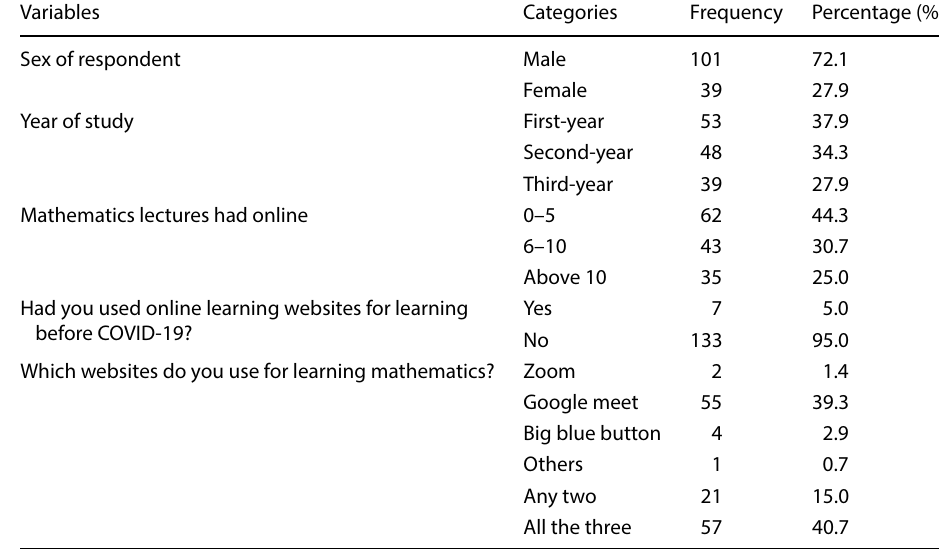
Table 1 Distribution of survey participants by demographic